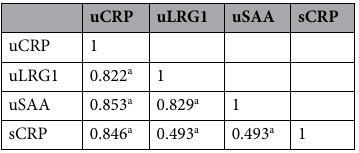
Table 5. Spearman’s rank correlation coefficient. a The P value is < 0.001.